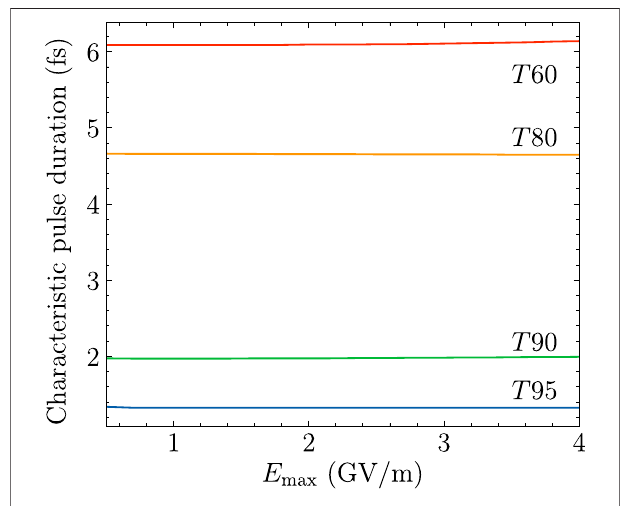
FIGURE 4 | Characteristic pulse durations T 95, T 90, T 80, and T 60 for (cid:2) 5, 10, 20, and 40%, respectively. See the text for more relative error δ P e P e